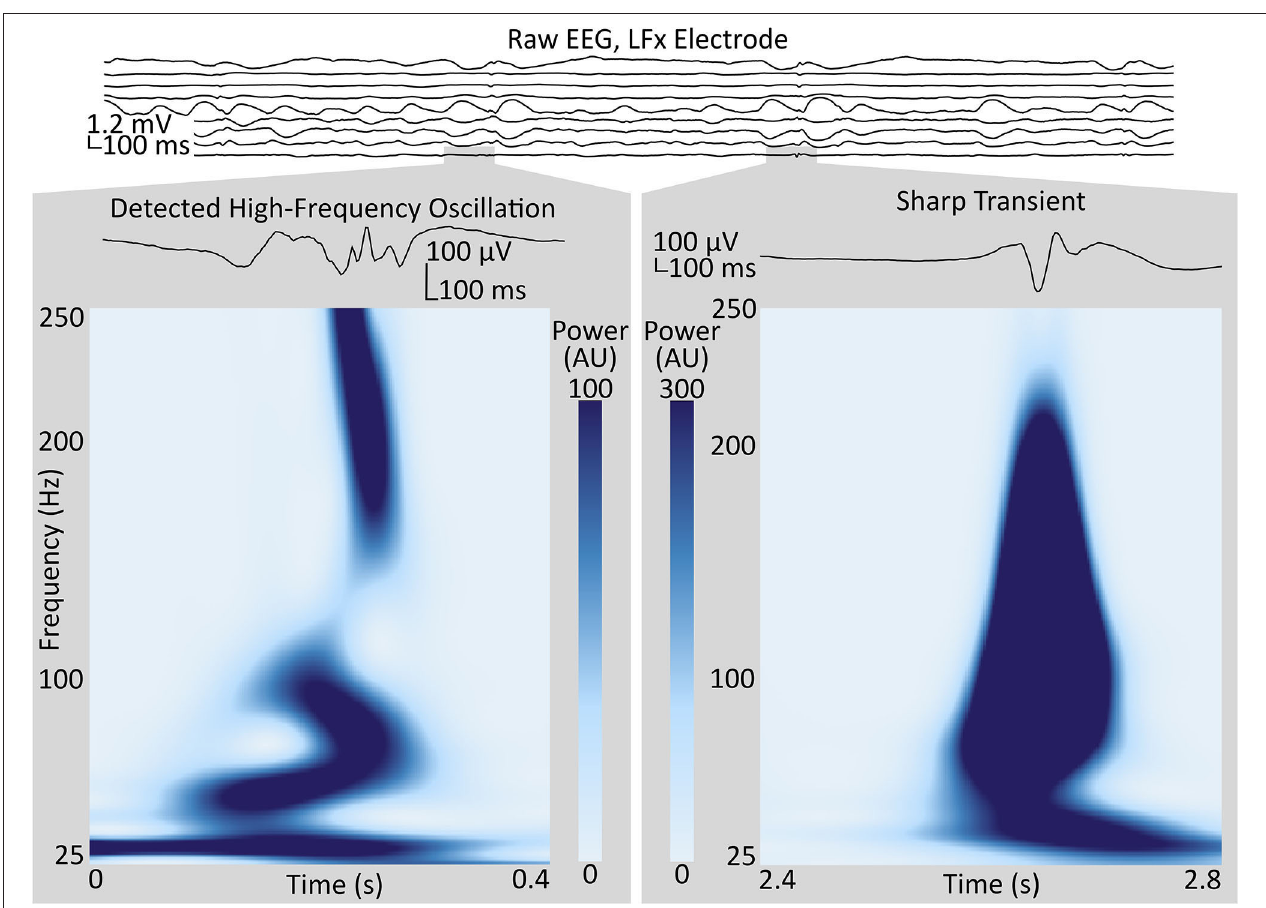
FIGURE 1 | Sample of intracranial EEG from the LFx depth electrode implanted in Subject 1, targeting the left frontal pole, with bipolar-referenced signals from contact pairs shown in spatial order, with the most-terminal contact on top. Two segments from the LFx9–10 (bottom) channel, in the anterior middle frontal gyrus, illustrate high-frequency events positively identified as an HFO (left), and not identified as an HFO (right), respectively, by the technique described in Methods (section High-Frequency Oscillations). Gray boxes show the enlarged waveforms and the spectrograms, as calculated by the Stockwell transform, of each segment. Contrast the multiple oscillations in the voltage trace and the trough in the power spectrum around 40Hz in the segment identified as an HFO to the single high-amplitude voltage spike and the broadband power increase in the segment rejected by the algorithm. HFO, high-frequency